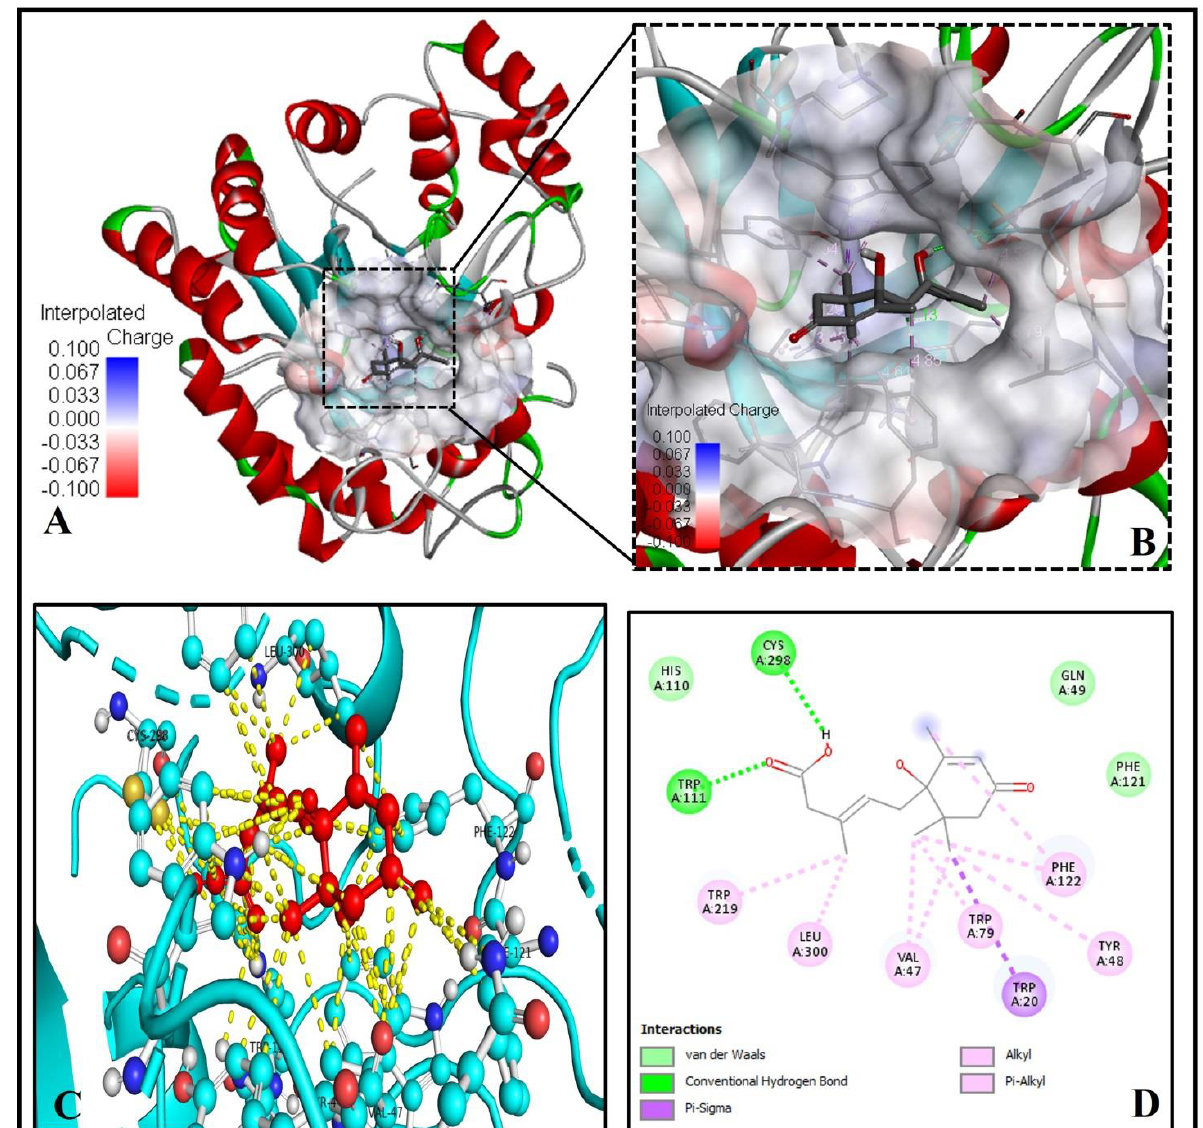
Figure 7. Molecular binding of ABA to aldose reductase (PDB ID: 3G5E). ( A ) Binding of ABA to the active site residues. ( B ) Magnified view showing the interpolated charge of amino acid residues of the binding cavity ( C ) The 3D image showing bonding (yellow dashed lines) of ABA (red ball and sticks) with residues of human aldose reductase (cyan ball and sticks). ( D ) 2D graph showing interactions at the molecular level of the binding compartment of aa residues with the ABA.